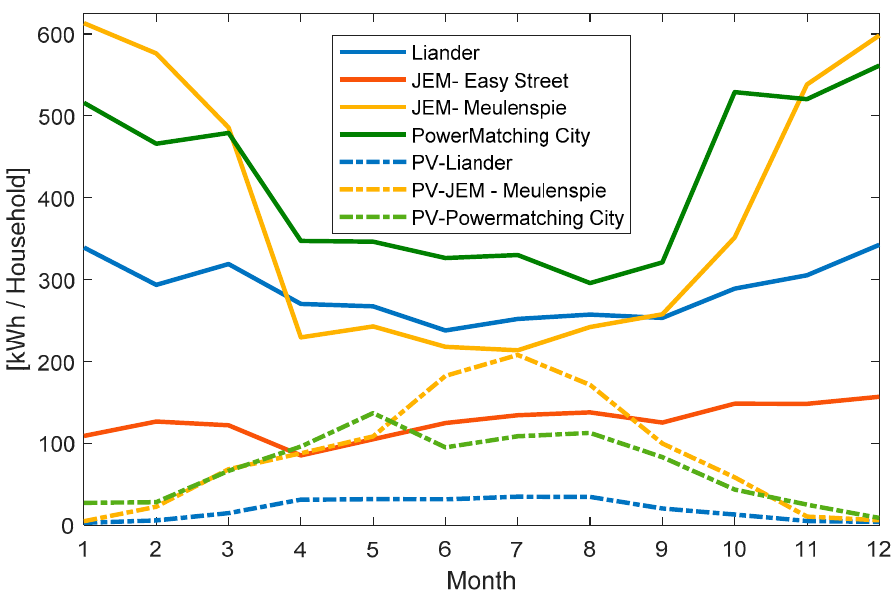
Figure 1. Monthly electricity consumption (solid line) and photovoltaic (PV) production (dashed line) profile over the year for all the datasets. JEM, Jouw Energie Moment.